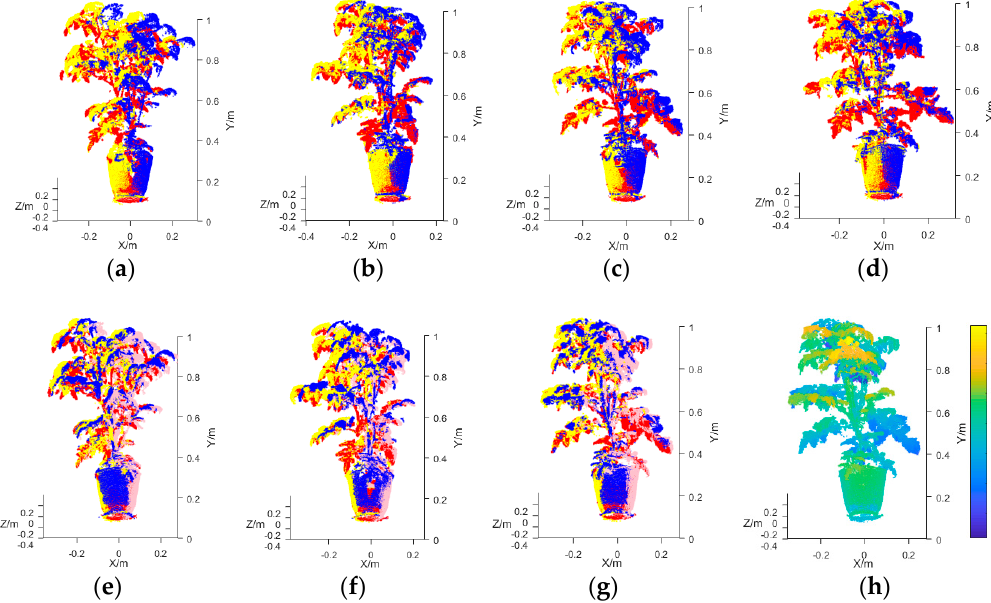
Figure 5. Results of the 3D point cloud reconstruction of a plant with different reconstruction methods: ( a ) V3-1; ( b ) V3-2; ( c ) V3-3; ( d ) V3-4; ( e ) V4-1; ( f ) V4-2; ( g ) V4-3; ( h ) depth map.